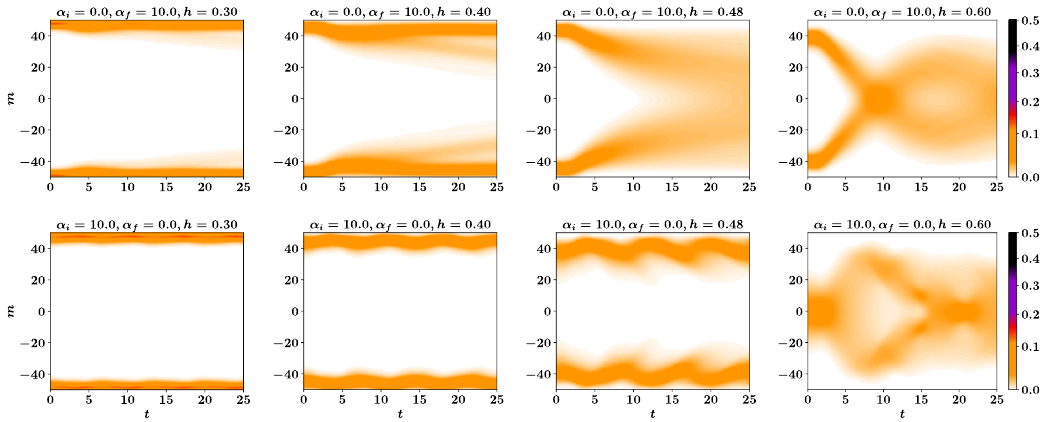
Figure 7: PDF dynamics of subsystem magnetization after a quantum quench along the direction of interaction range, α . The first row shows the results for quenches = 0.0 and quenched to a final α = 10.0, the where the system is initialized at α i f second row shows the results for opposite condition. The quenches are performed for four representative values of transverse field h ∈ { 0.30,0.40,0.48,0.60 }